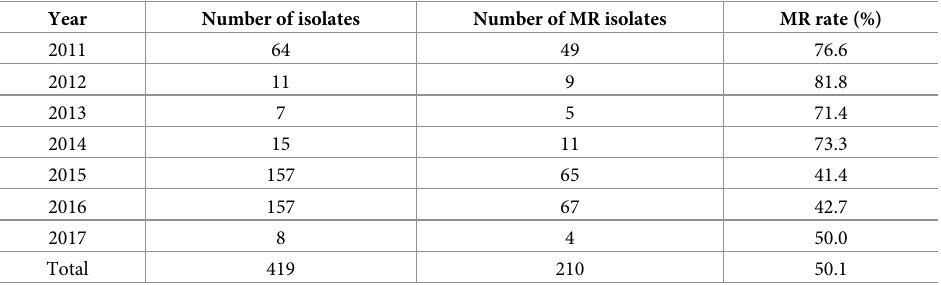
Table 1. Number of M . pneumoniae isolates collected in this study and macrolide resistance